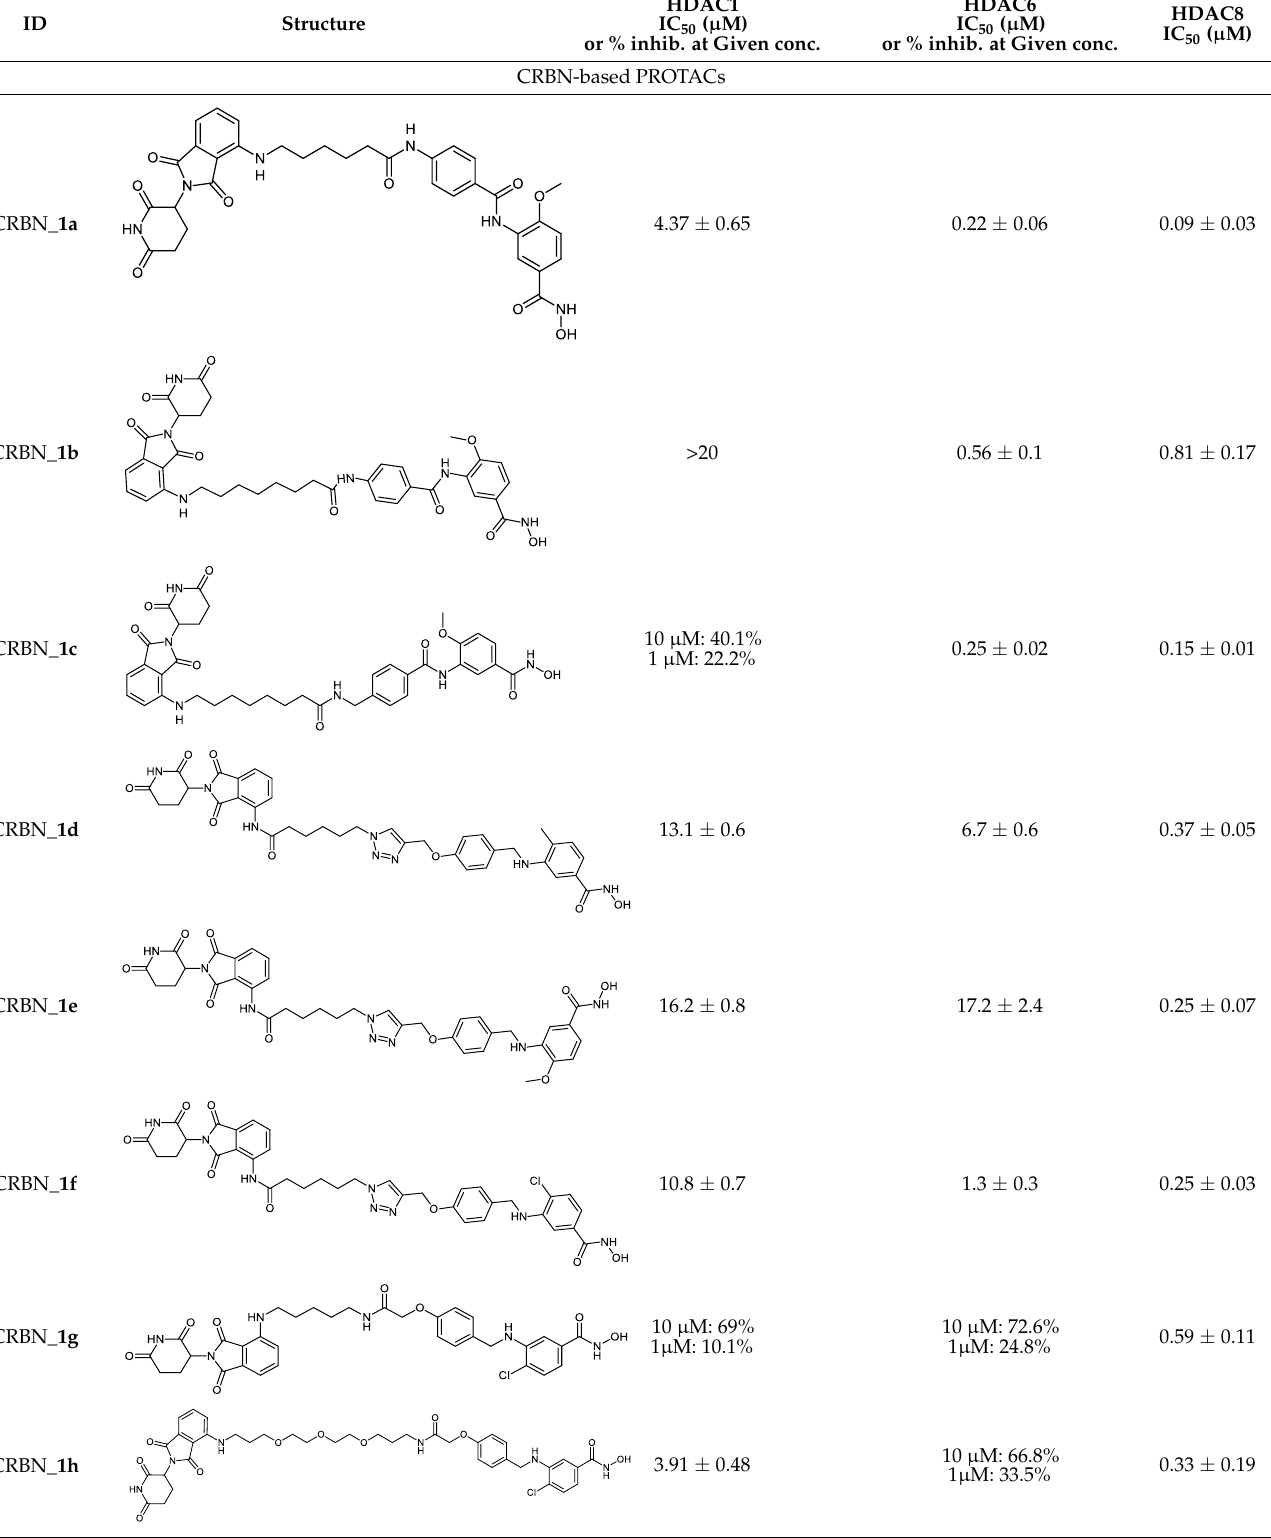
5 of 34 Figure 2. ( A ) First PROTACs to enter in-human clinical trials (https://www.guidetopharmacol- ogy.org (accessed on 1 March 2022)). ( B ) Examples of reported bifunctional hydrophobically tagged molecules. ( C ) Reported HDAC8 PROTAC. In the past few years, increasing interest in targeting HDACs using the PROTAC technology developed. In 2018, we published the development of the first degrader of an epigenetic eraser protein which was the Sirt2 deacetylase [27]. In the same year, Yang et al. were able to synthesize the first HDAC6 PROTAC utilizing a non-selective HDAC- inhibitor [45]. After the development of this degrader, several PROTACs targeting HDAC6 enzyme were developed [46,47]. Furthermore, a first-in-class HDAC3 specific PROTAC was reported [48]. Recently, Chotitumnavee et al. [49] reported the development of an HDAC8 PROTAC. In the three synthesized degraders, a reported NCC-149 analogue [11] was used as POI ligand and pomalidomide was used as the E3 ubiquitin ligase ligand. Both war- heads were connected with aliphatic linkers of three different lengths. From the synthe- sized degraders, Compound XIII (Figure 2C) resulted in efficient degradation of HDAC8 enzyme in T-cell leukemia Jurkat cells without affecting the levels of HDACs 1, 2, and 6. In the present work, we aimed at the development of bifunctional molecules that po- tently and selectively degrade HDAC8 in neuroblastoma cells, while not affecting the ac- tivity of the other HDAC isozymes. A further focus was the analysis of the antiprolifera- tive effects of the PROTACs in neuroblastoma cell lines. 2. Results and Discussion 2.1. Design Concept The developed PROTACs (Table 1) were built based on previously published HDAC8 inhibitors possessing IC 50 values in the low nanomolar range [16,50] (Table 2) In previous studies, we found that benzhydroxamates showed good HDAC8 inhibitory ac- tivity and selectivity over HDAC1 and 6. Crystallographic studies, as well as molecular docking studies on several HDAC subtypes [51], revealed that the selectivity of this series of compounds can be attributed to the fact that the aromatic capping group occupies an